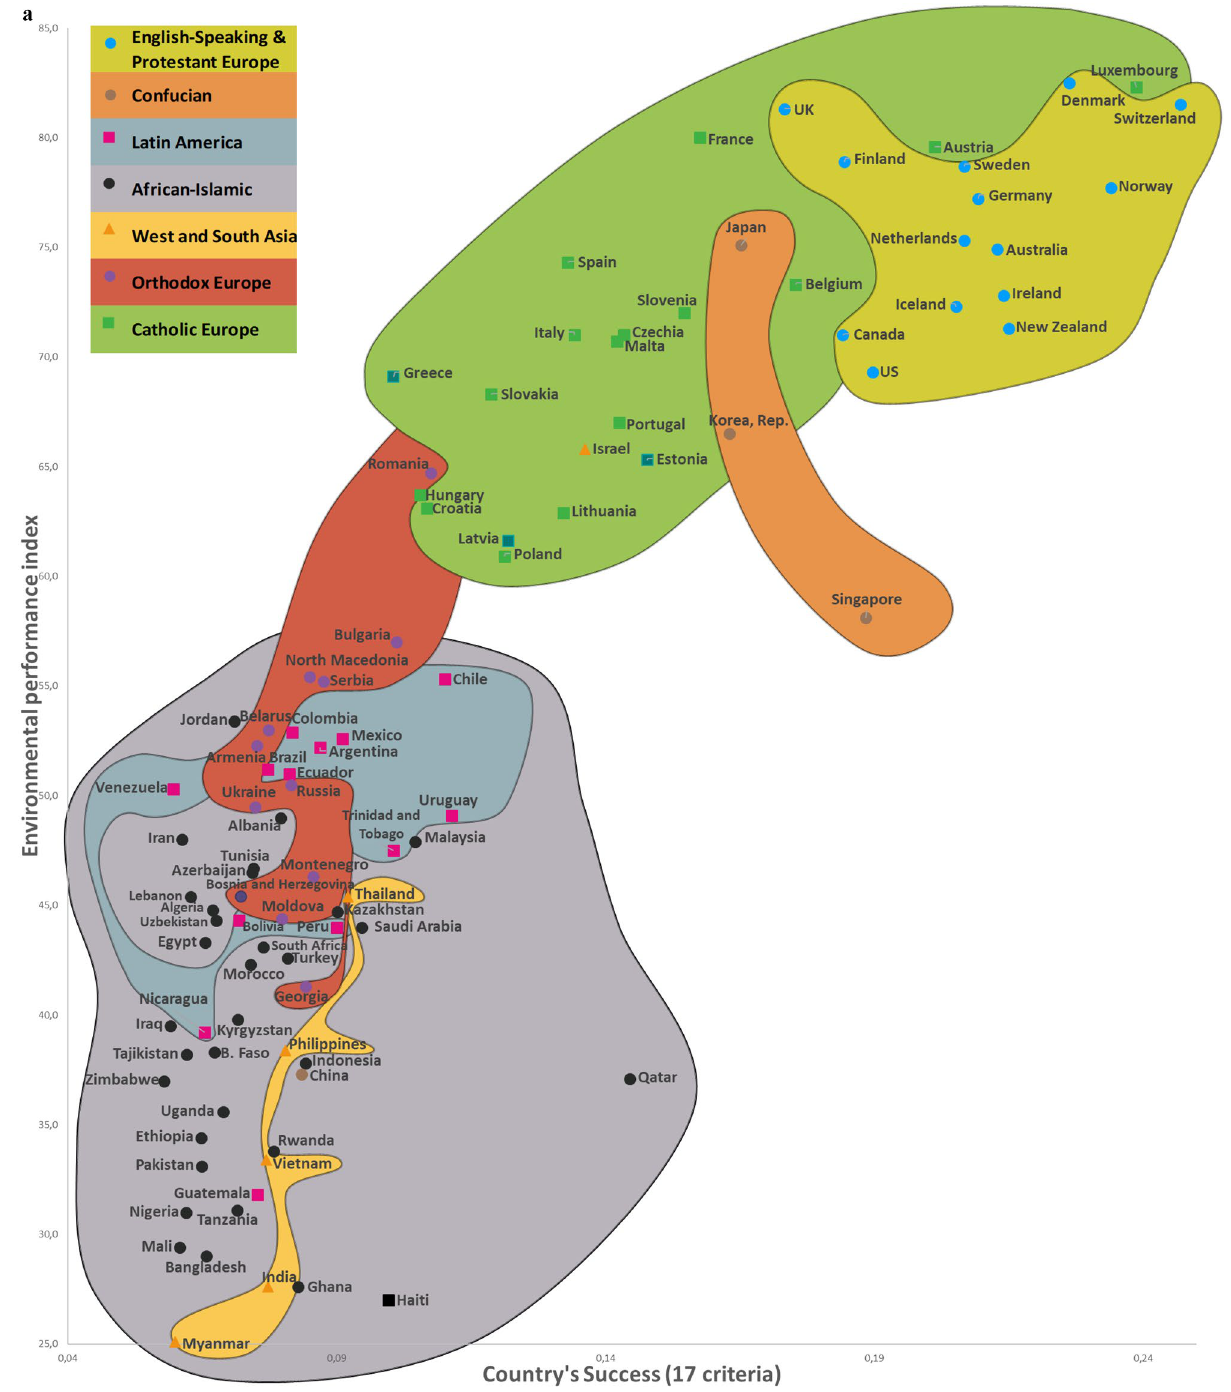
Figure 2. Country success and environment sustainability world maps: ( a ) CSS EPI map. ( b ) CSS air quality map. ( c ) CSS climate change